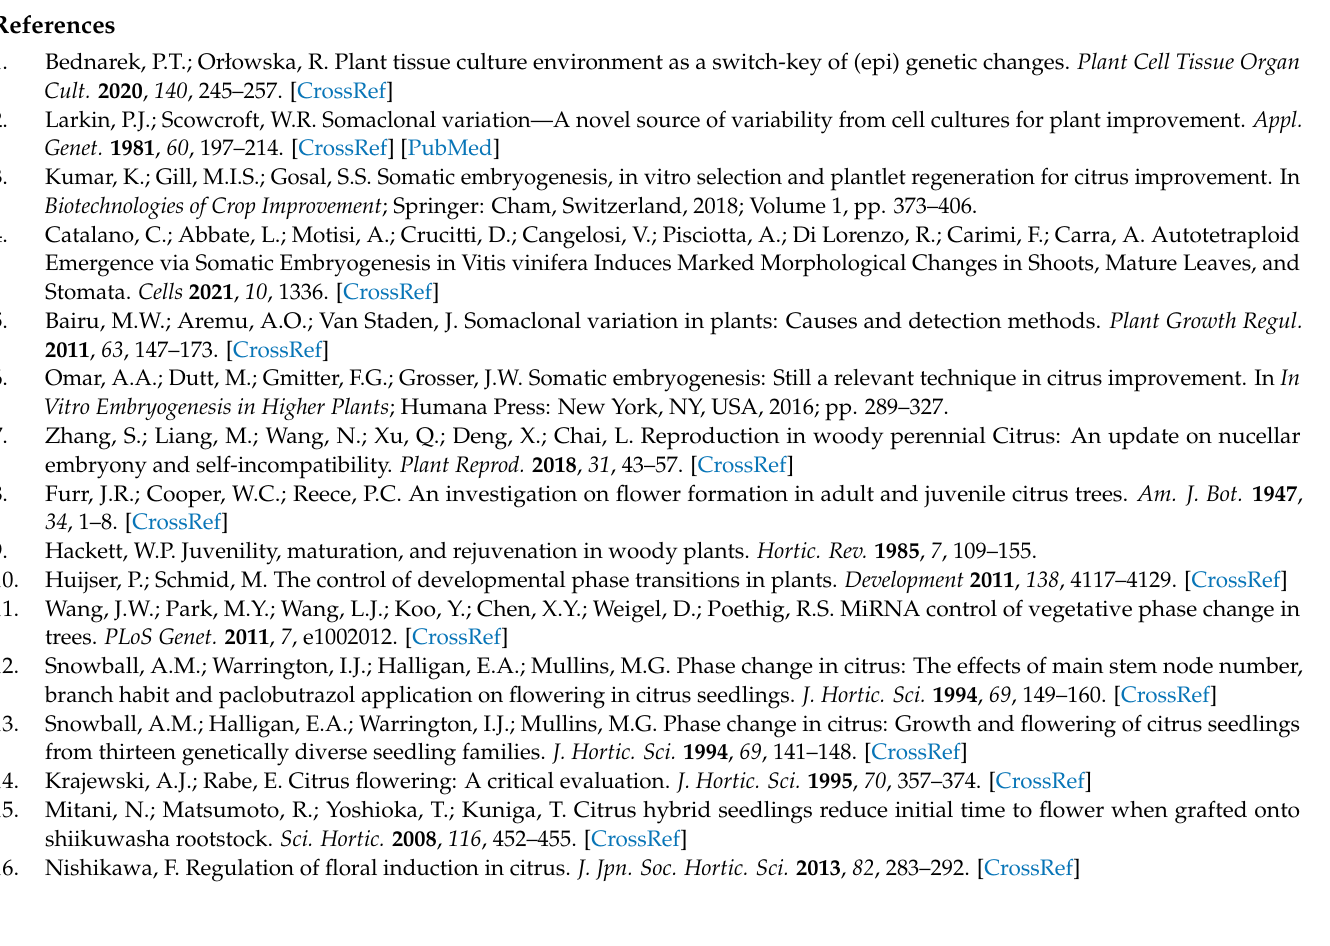
Figure S2: Representative images of molecular markers: ( A ) Patterns of mother plant (M) and 16 regenerated plantlets (R1-16) of Citrus deliciosa ‘Tardivo di Ciaculli’ obtained with the ISSR primer UBC-835. L, 100 bp ladder; ( B ) Patterns of mother plant (M) and 16 regenerated plantlets (R1-16) of Citrus sinensis ‘Valencia late’ obtained with the RAPD primer OPM04. L, 100 bp ladder, Table S1: Primer sequences and annealing temperatures used for ISSR analysis, Table S2: Primer sequences used for RAPD